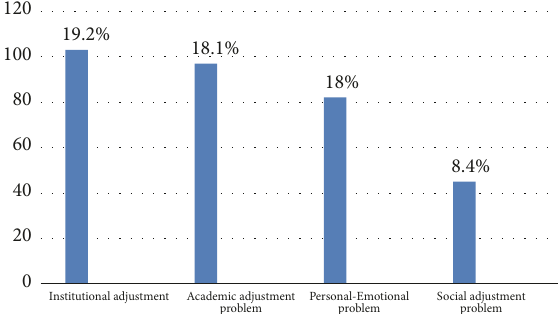
Figure 2: Prevalence of different adjustment problem among university students in Dilla University, Southern Ethiopia, 2016